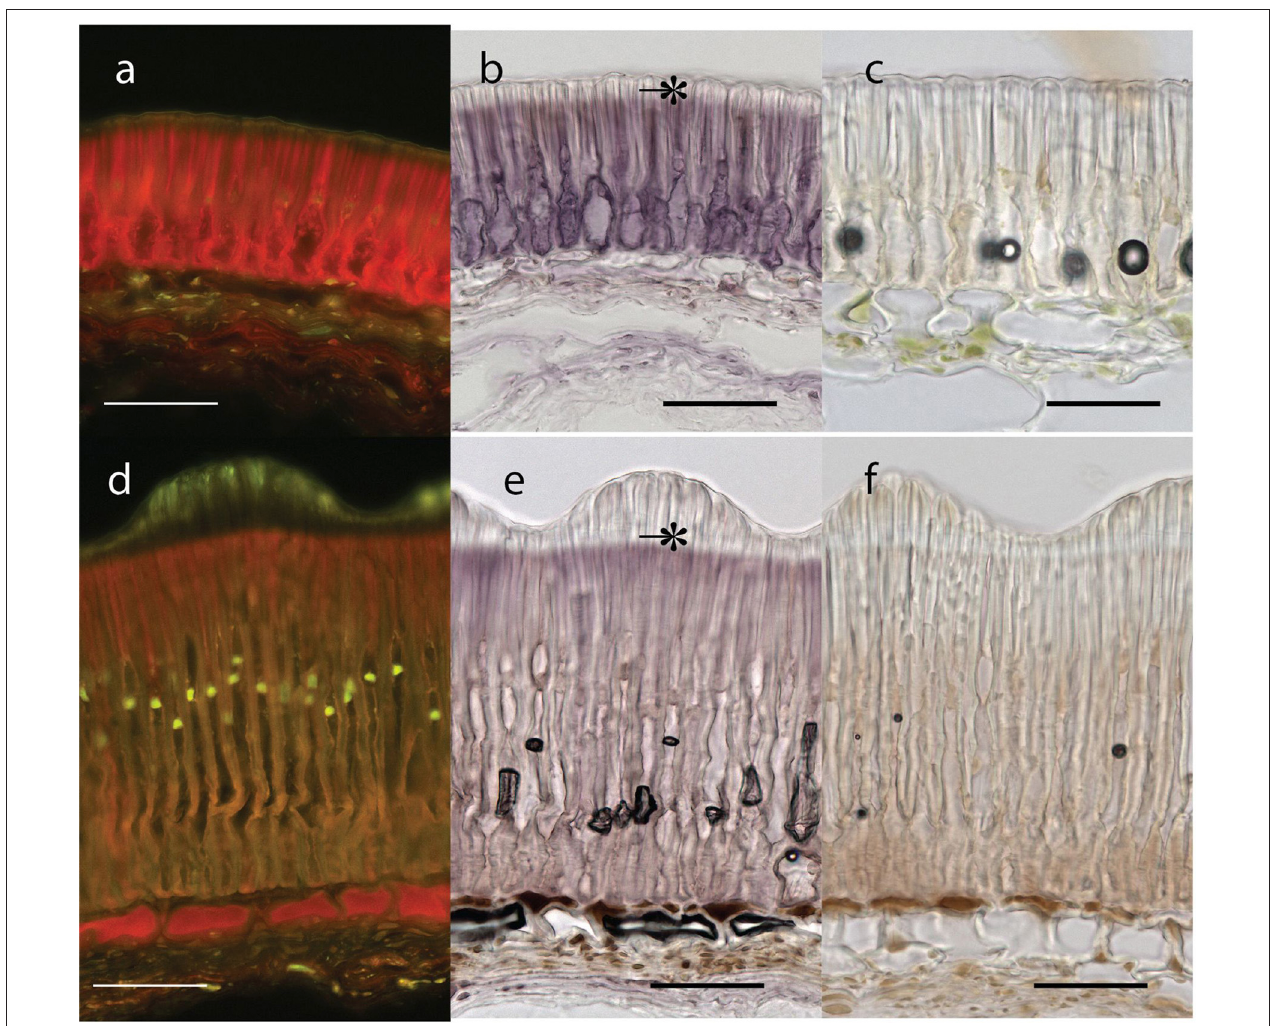
FIGURE 4 | Seed coat transverse sections from extrahilar region stained with DMACA for proanthocyanidins polyphenolics (bar = 50 µ m): Upper row—JI92, Lower row—JI64. Blue excited red fluorescence of DMACA (a,d) and violet coloration in bright field (b,e) . Similar sections as in (c,f) but stained with DMACA after mild alkaline hydrolysis; scale bars = 50 µ m. *, Light